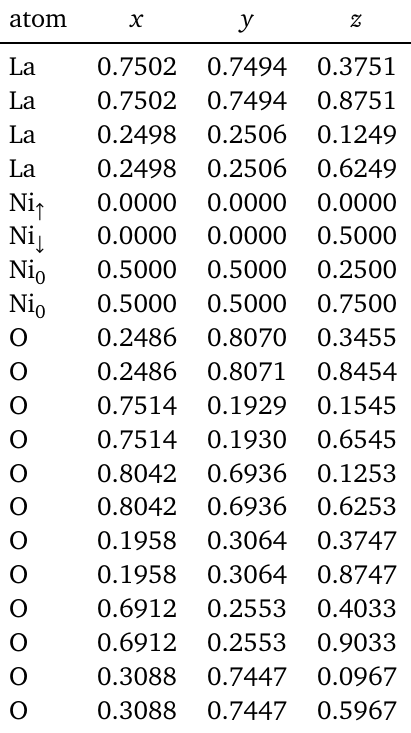
The relaxed atomic positions of the disproportionated antiferromag- netic R phase. The atomic positions are given relative to the primitive lattice vectors. The lattice parameters are a = 5.4064, b = 5.4078, c = 10.8092 Å, α = 61.306 ◦ , β = 61.315 ◦ , and γ = 61.167 ◦